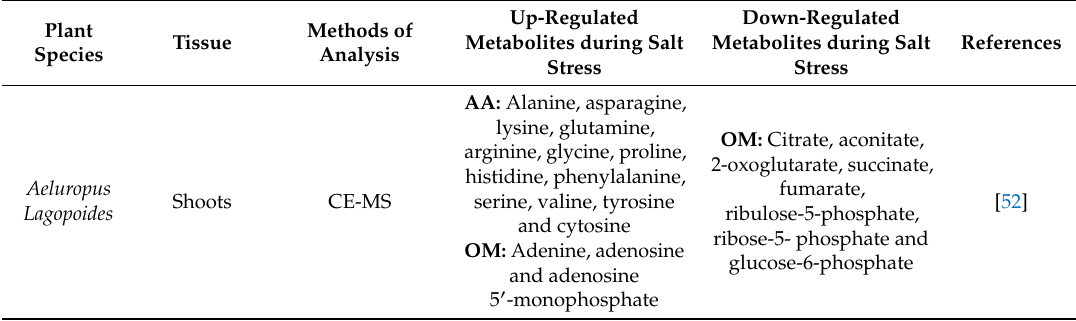
Table 1. Identification of important up-regulated and down-regulated metabolites in various plant species in response to salt